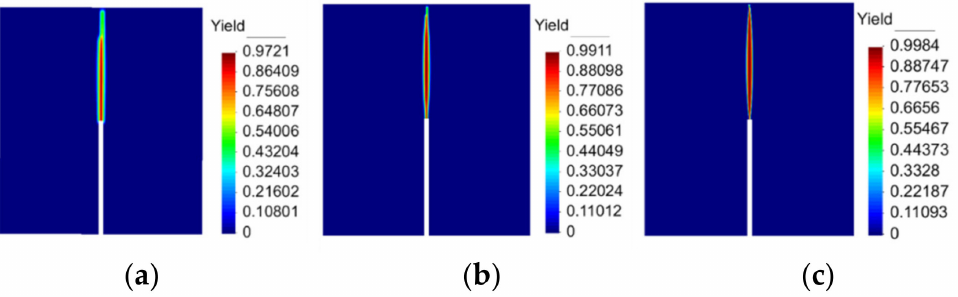
Figure 8. Distribution of concrete damage by different meshes: ( a ) Coarse mesh; ( b ) Middle mesh; ( c ) Fine mesh.